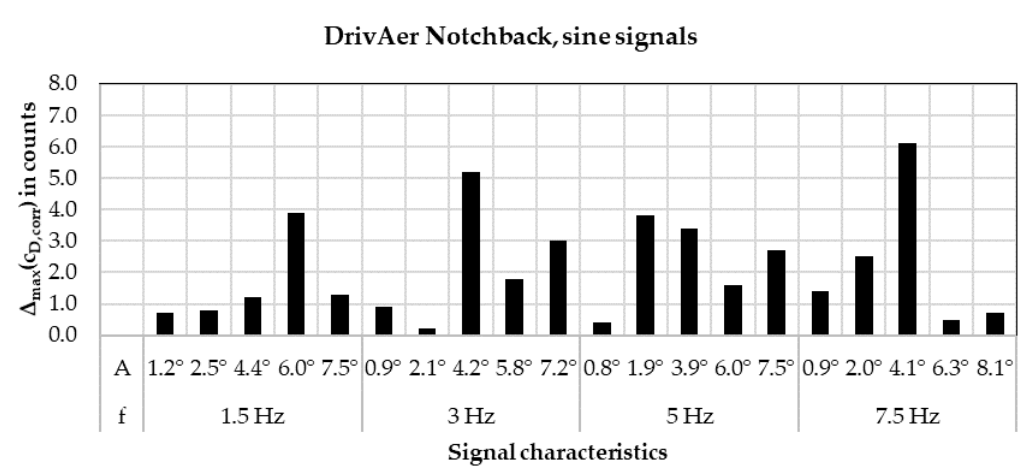
Figure 11. Maximum delta between the three corrected c D values for the DrivAer notchback, measured with sine signals.